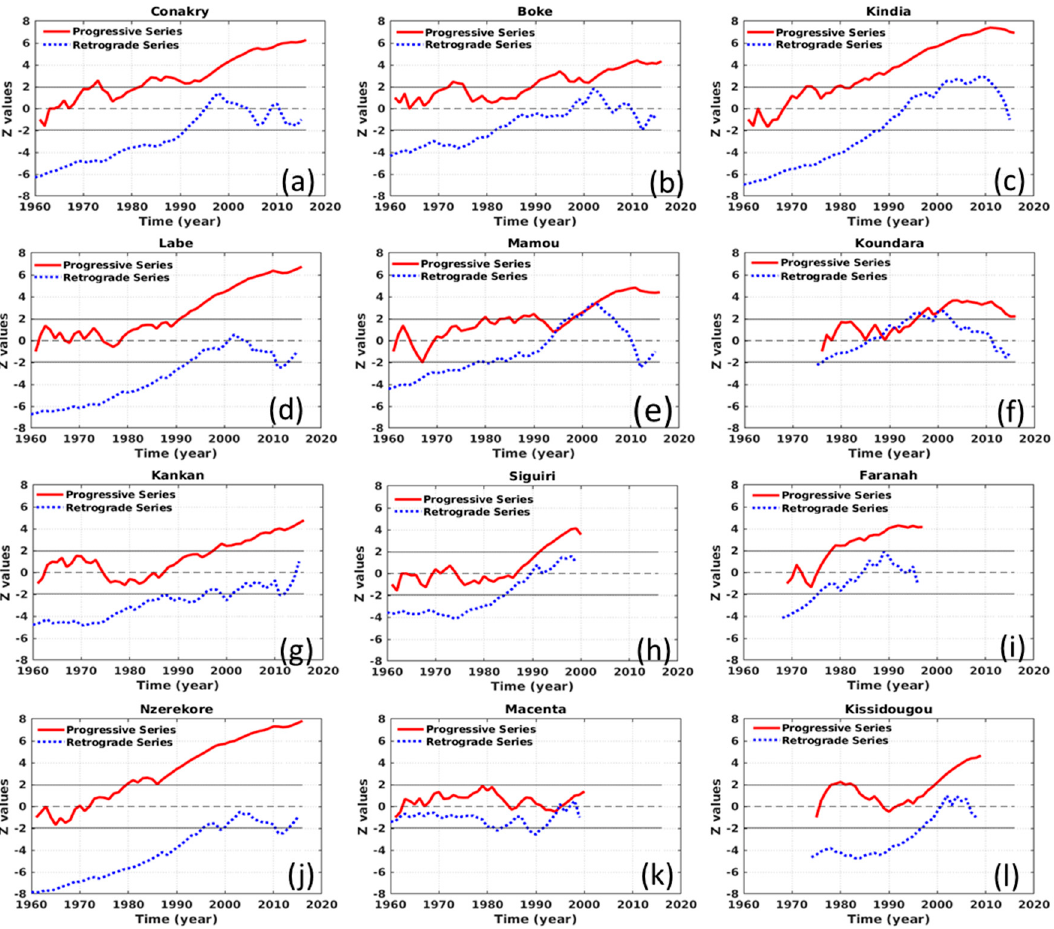
Figure 9. Sequential Mann-Kendall analysis of the annual trend of Lower-Guinea ( a – c ), Middle-Guinea ( d – f ), Upper-Guinea ( g – i ) and Forest Guinea ( j – l ). The red curves denote the forward sequential values of the statistic u(t), and the blues curves denote the backward sequential values of the statistics.